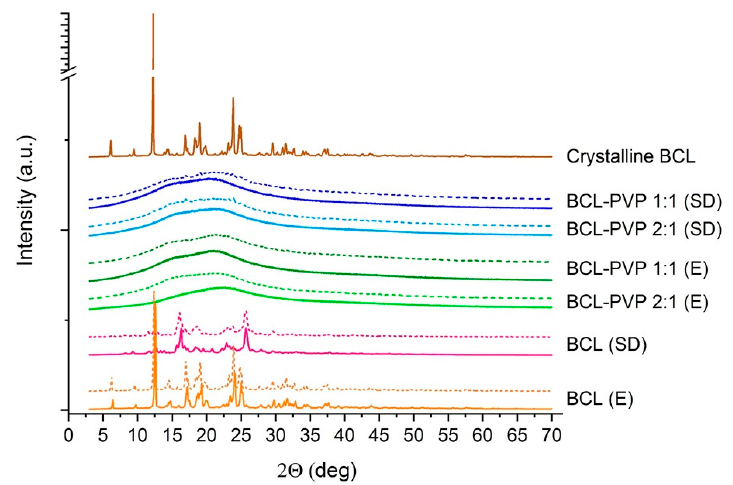
Figure 1. X-ray diffraction patterns of crystalline bicalutamide (BCL) and BCL–PVP (polyvinylpyrrolidone) binary systems obtained by either evaporation (E) or spray drying (SD) measured two days (solid lines) and six months (dotted lines) after preparation.